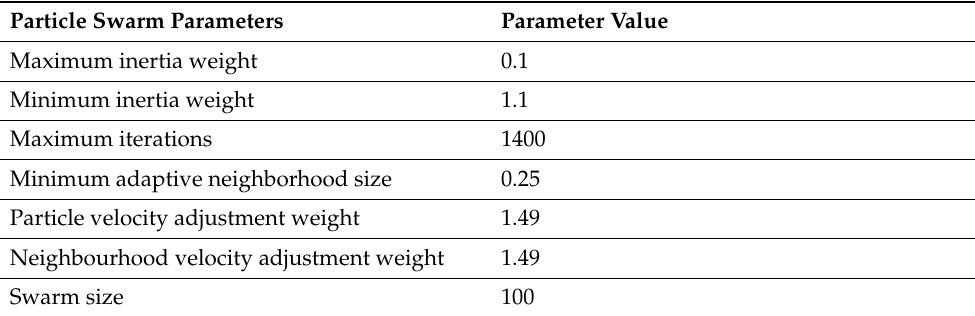
Table 5. Parameters used in the particle swarm optimization algorithm.